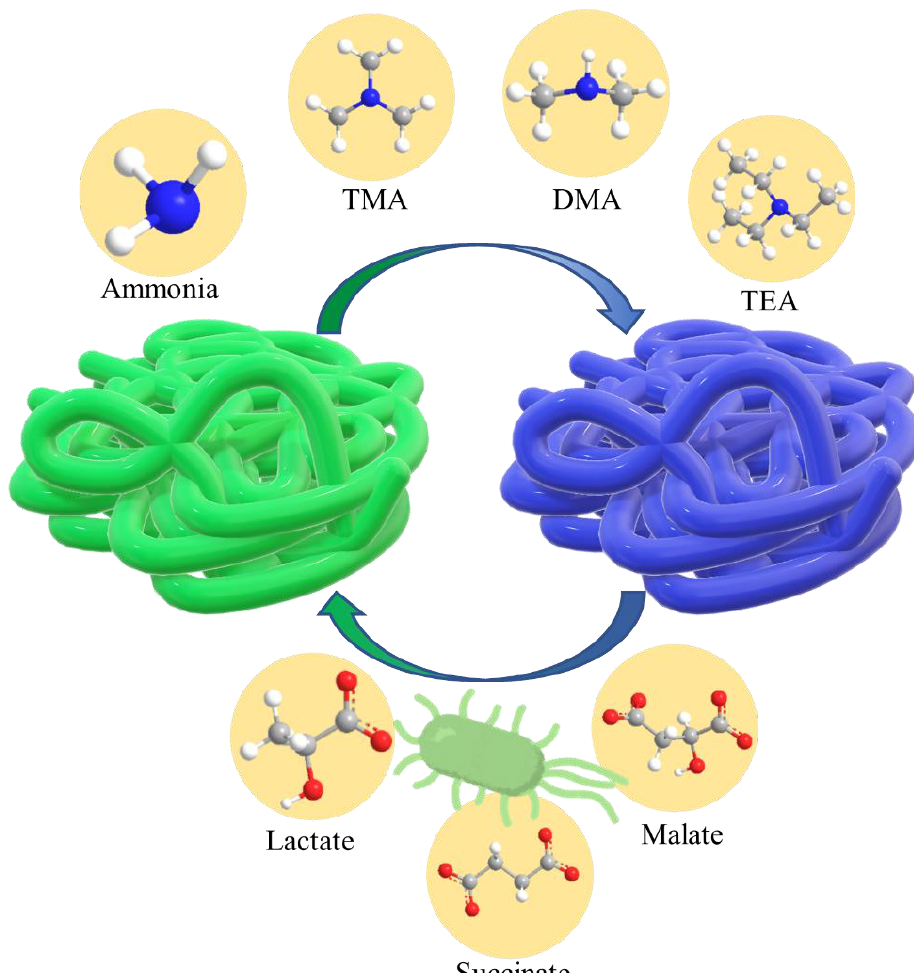
Figure 9. PANI as a colourimetric sensor for the indication of food freshness.